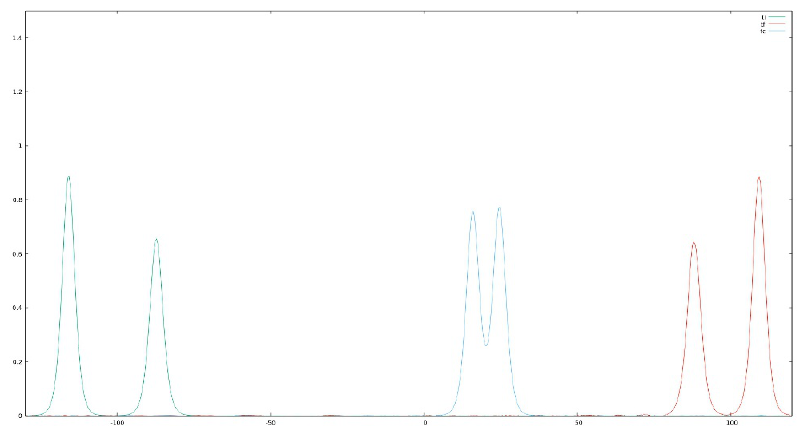
Figure 2 . Numerical simulation of 2-soliton collision for three successive times, t i , before collision (green); t c , collision (blue) and t f , after collision (red); for the parameter values (cid:15) 1 = 1 : 2 ; (cid:15) 2 = 0 : 9 ; (cid:11) = 4 ; k 1 = 0 : 75 ; k 2 = 0 : 71 ; a 1 = a 2 = 1, such that the initial condition in (7.1) considers (cid:14) 1 = 87 ; (cid:14) 2 = 62 ; t i = 0 and b j = c j = 0 ( j = 1 ; 2).